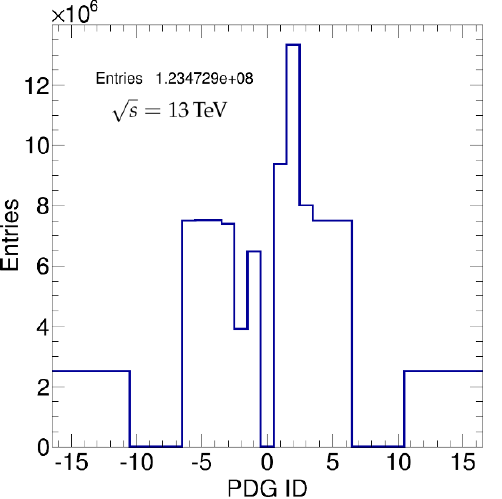
Figure 1 . The number of each of the fermion types (PDG IDs [24]) coming directly from 10 7 sphaleron-like transitions and CT10